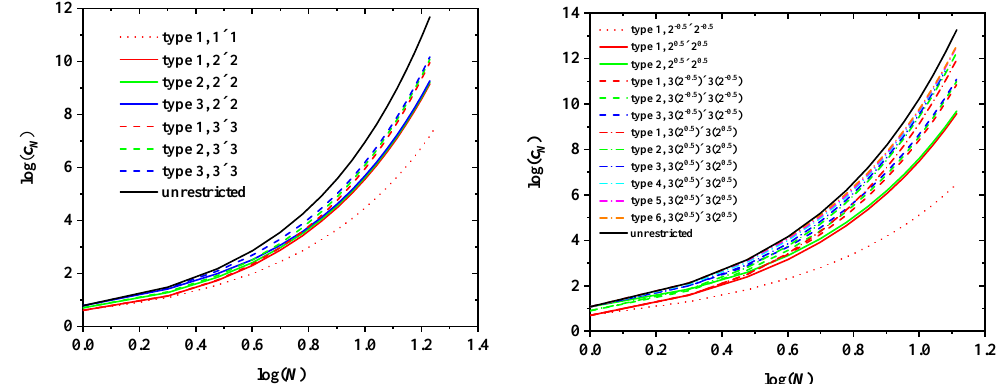
Figure 6. Log-log plot of the number of distinct SAW configurations, c N , versus the number of SAW steps, N , for the SC (left panel) and the FCC (right panel) lattices. Tube cross-sections correspond to 1 × 1, 2 × 2 and 3 × 3 for SC and to 0.5 For a given lattice and confining tube, results are shown for every possible distinct SAW origin (type). Also shown for comparison are the corresponding curves for the unrestricted lattices (solid black lines).